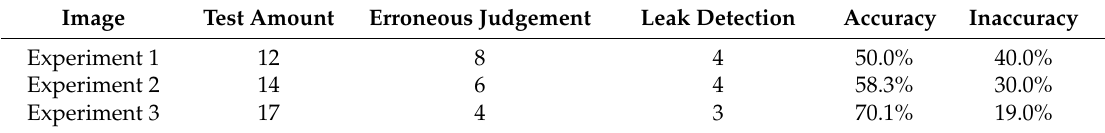
Table 3. Bamboo forest extraction accuracy.